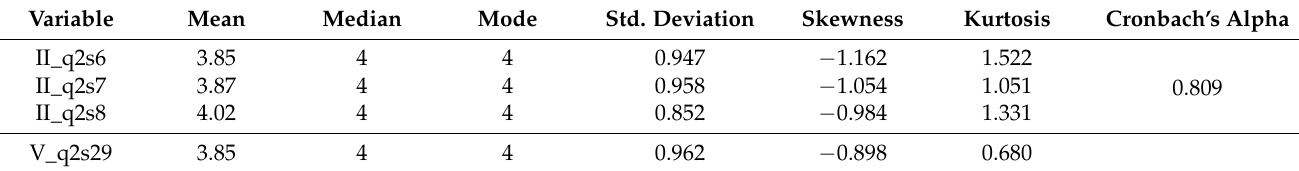
Table 5. Operational capabilities and descriptive statistics from the survey responses.